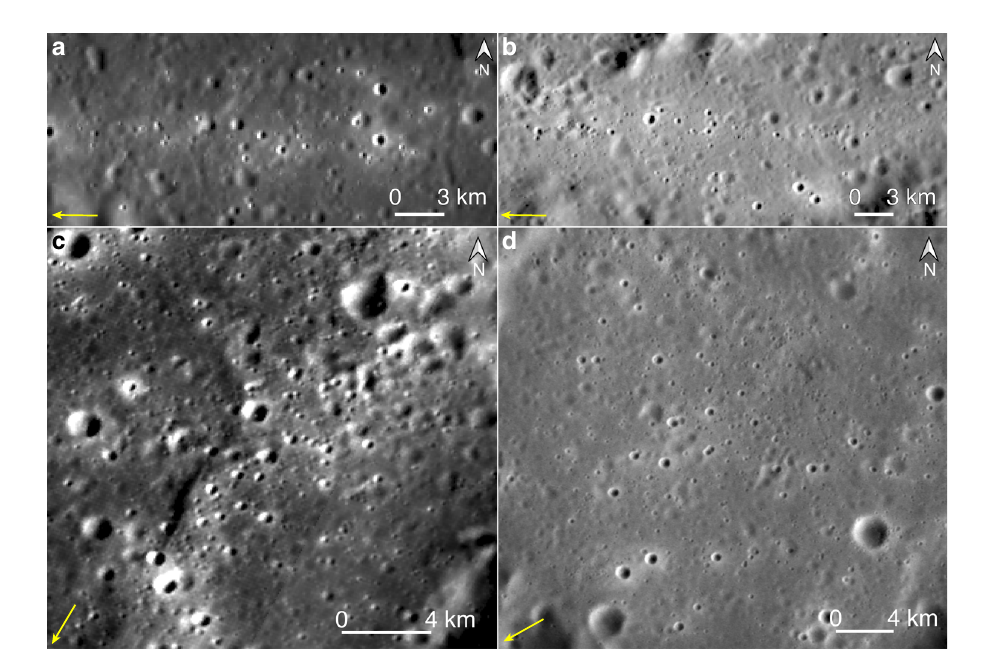
Fig. 3 | Chains of secondaries in the curved ray on Mercury. a – d Chains of secondaries in the western, eastern, and orientational in fl ection branches of the curvedray,respectively.TheirlocationsaremarkedinFig.1d.Yellowarrowsdenote